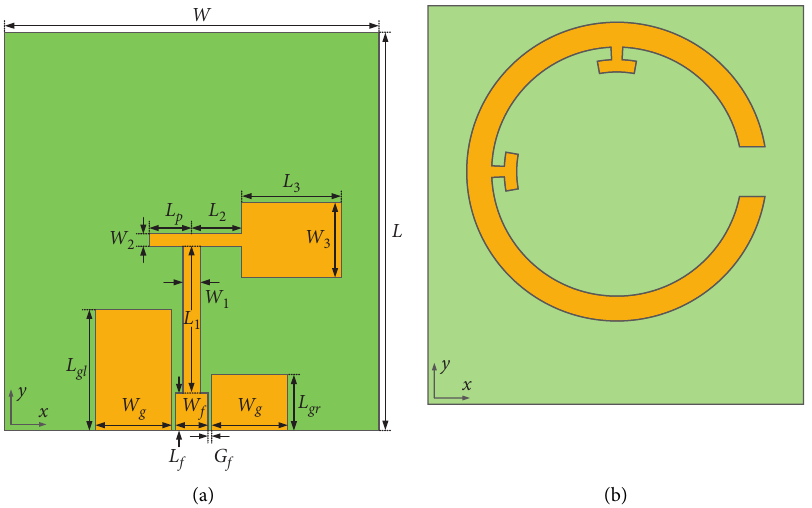
Figure 6: Geometrical of the proposed antenna: (a) Top view ( W � 30, L � 32, W